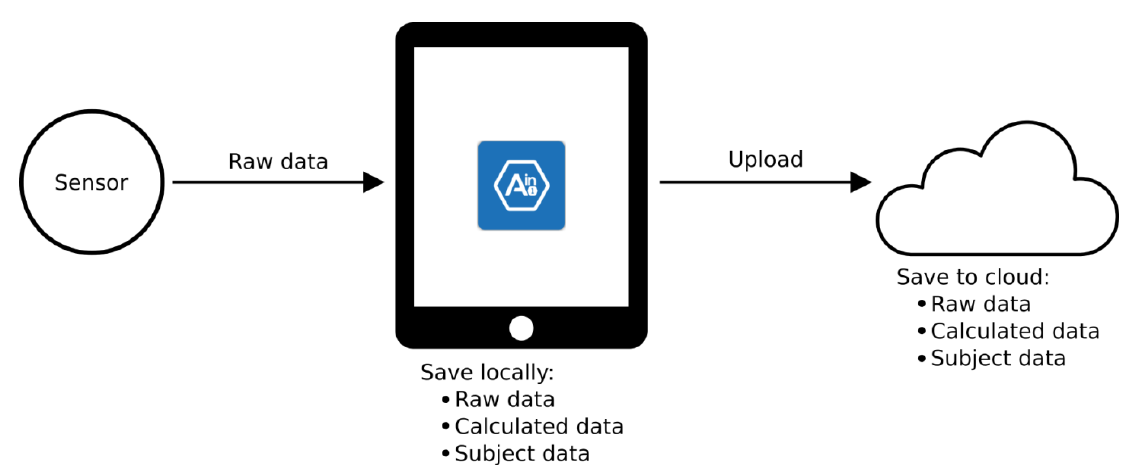
Figure 5. Data handling of the pilot prototype.